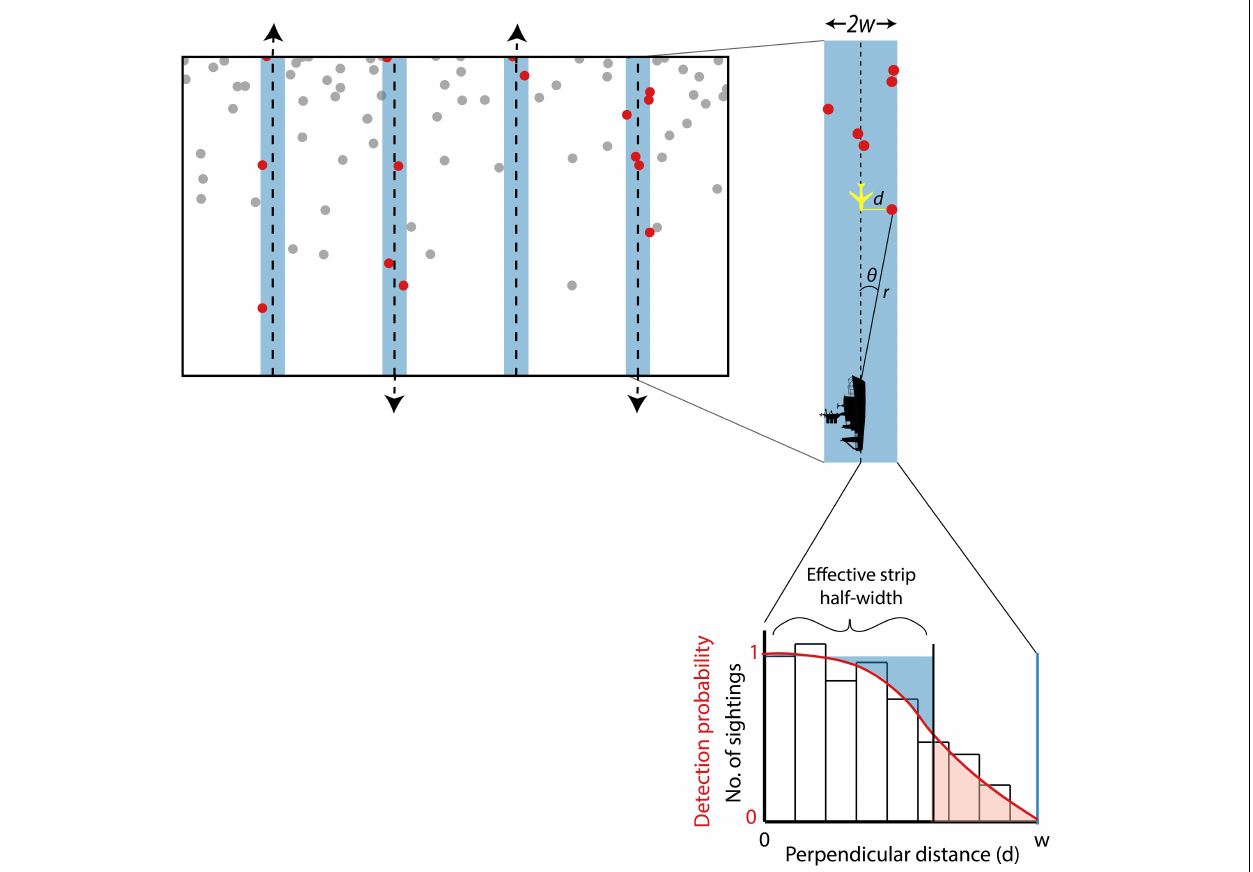
FIGURE 1 | Schematic representation of the elements of a line transect survey. Illustration of a sampling design (top left) in which parallel lines are placed equidistant from each other (other designs such as zig-zag lines could also be appropriate). The starting point for the first line is random so that the design satisfies the requirements for an equal coverage probability design (see text). The shaded areas around the lines represent the strip searched by observers as they progress in the direction of travel indicated by the arrows at the end of each line. The dots represent animals (or groups of animals); red dots are those within the searched strip. In a strip transect survey, all the animals represented by red dots are assumed to be detected. In a line transect survey, animals further from the transect line are less likely to be detected so not all of the animals represented by red dots may actually be sighted. Note that animals are not distributed randomly across the survey area – density is higher toward the top than the bottom. This design follows good practice in placing lines perpendicular to the density gradient (if known) to minimize inter-line variability in the number of animals detected and thus maximize precision in abundance estimation. To the right is an illustration of data collection on one of the transect lines. The width of the strip searched on each side of the line is defined as w . When an animal (or group of animals) is detected from the ship, observers measure the distance r and the angle θ , from which perpendicular distance from the transect line, d , can be calculated as r x sin θ . Perpendicular distance is measured directly from the aircraft when it comes abeam of the animal. On completion of a survey, the perpendicular distances measured to all the detected animals or groups can be plotted as a frequency histogram. Note that the frequency of animals detected declines as perpendicular distance increases away from the transect line (zero perpendicular distance). The red curved line represents the detection function fitted to the perpendicular distance data, with detection probability = 1 at perpendicular distance = 0, as assumed in line transect analysis (see text). The effective strip half-width, esw (average detection probability x w , see text), is the perpendicular distance at which the number of animals detected at greater distances (represented in pink) equals the number of animals present but not detected at lesser distances (represented in